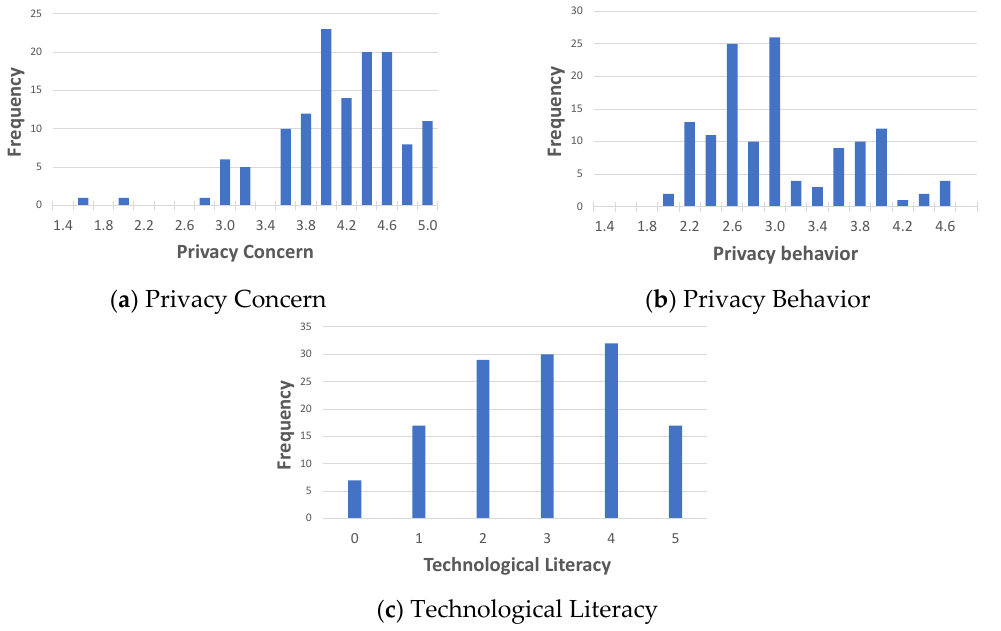
Figure 4. Distributions of privacy concern, privacy behavior, and technological literacy.